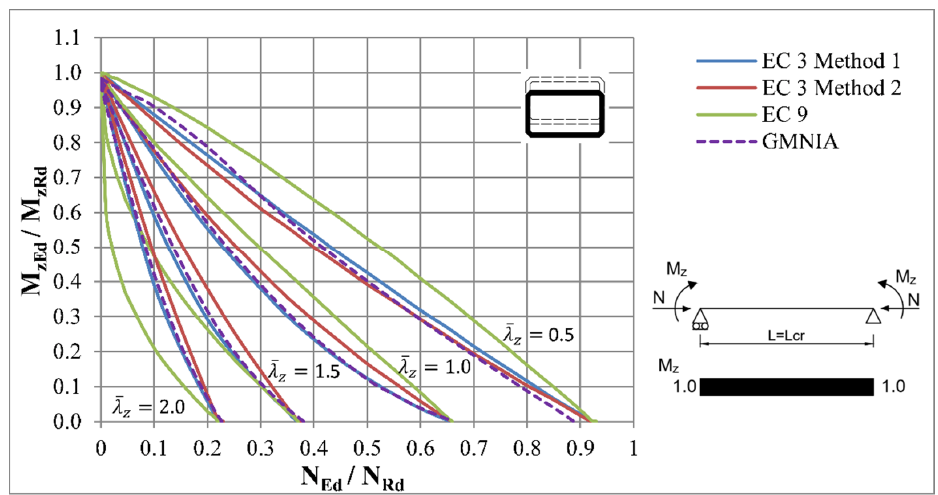
Figure 44. Interaction curves for weak axis flexural buckling of beam-columns with RHS cross-section.